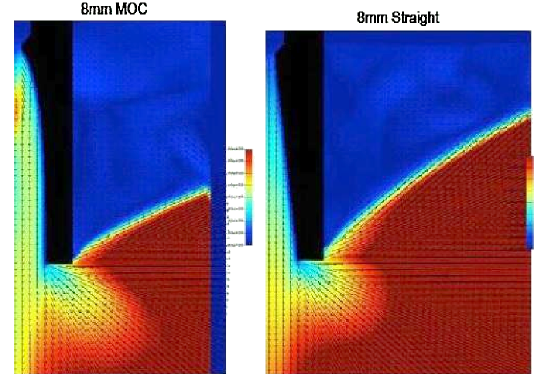
fields.FIG. 8. 8 mm MOC nozzle radial density lineouts for 0 (black), 1 (blue), 2 (red), and 3 (teal) mm downstream of the nozzle exit at 20 (cid:1) s